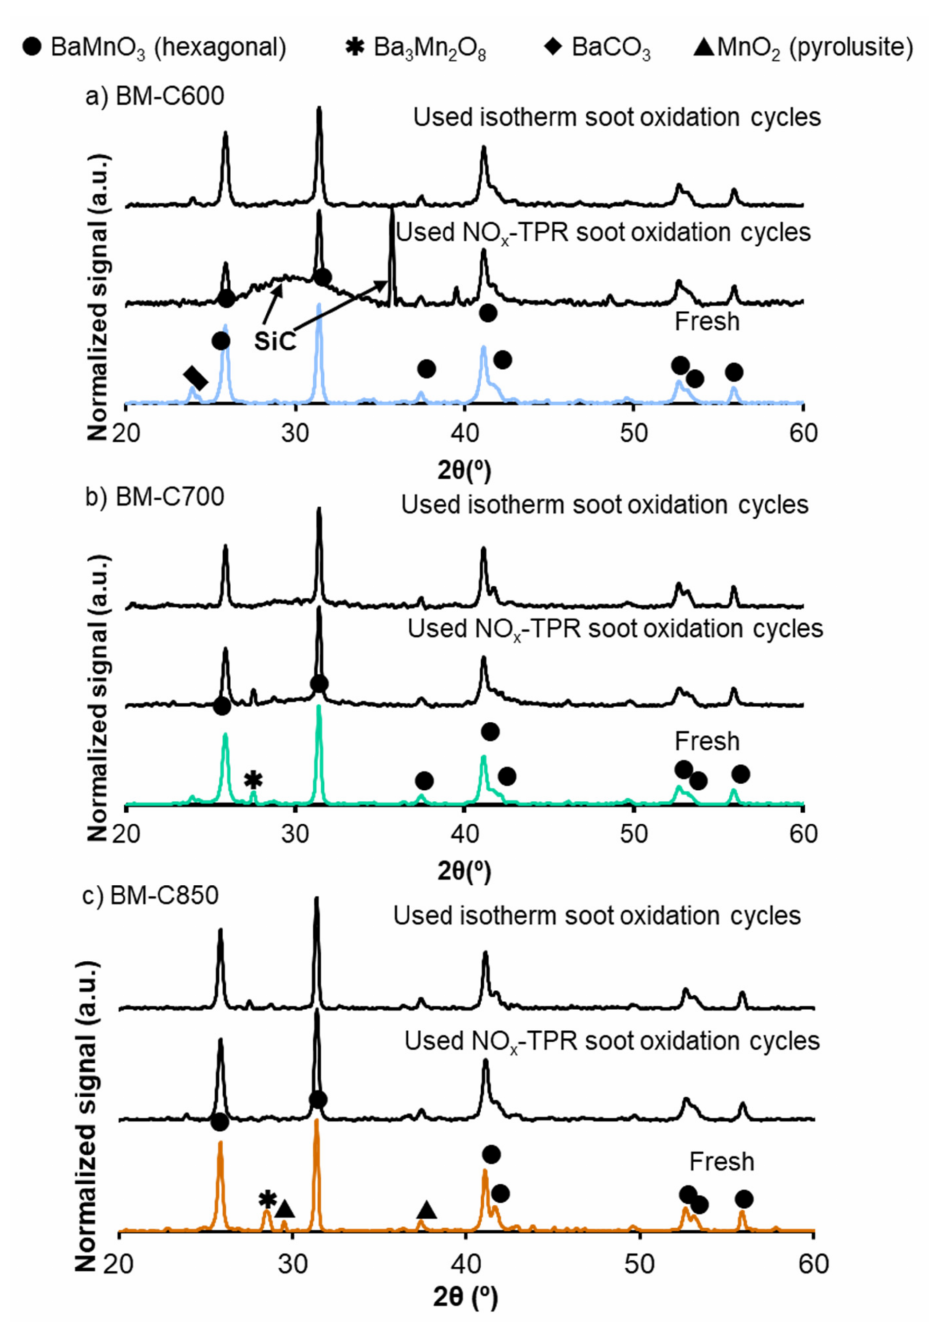
Figure 15. X-ray patterns of fresh and used BM-CX catalysts: after three NO x -TPR consecutive cycles and two isothermal soot oxidation cycles at 450 ◦ C: ( a ) BM-C600, ( b ) BM-C700 and ( c )